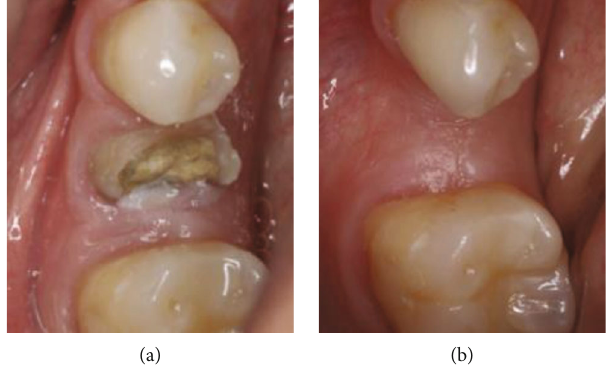
Figure 7: Occlusal view of the lower left second premolar site: (a) before the extraction; (b) 4 months